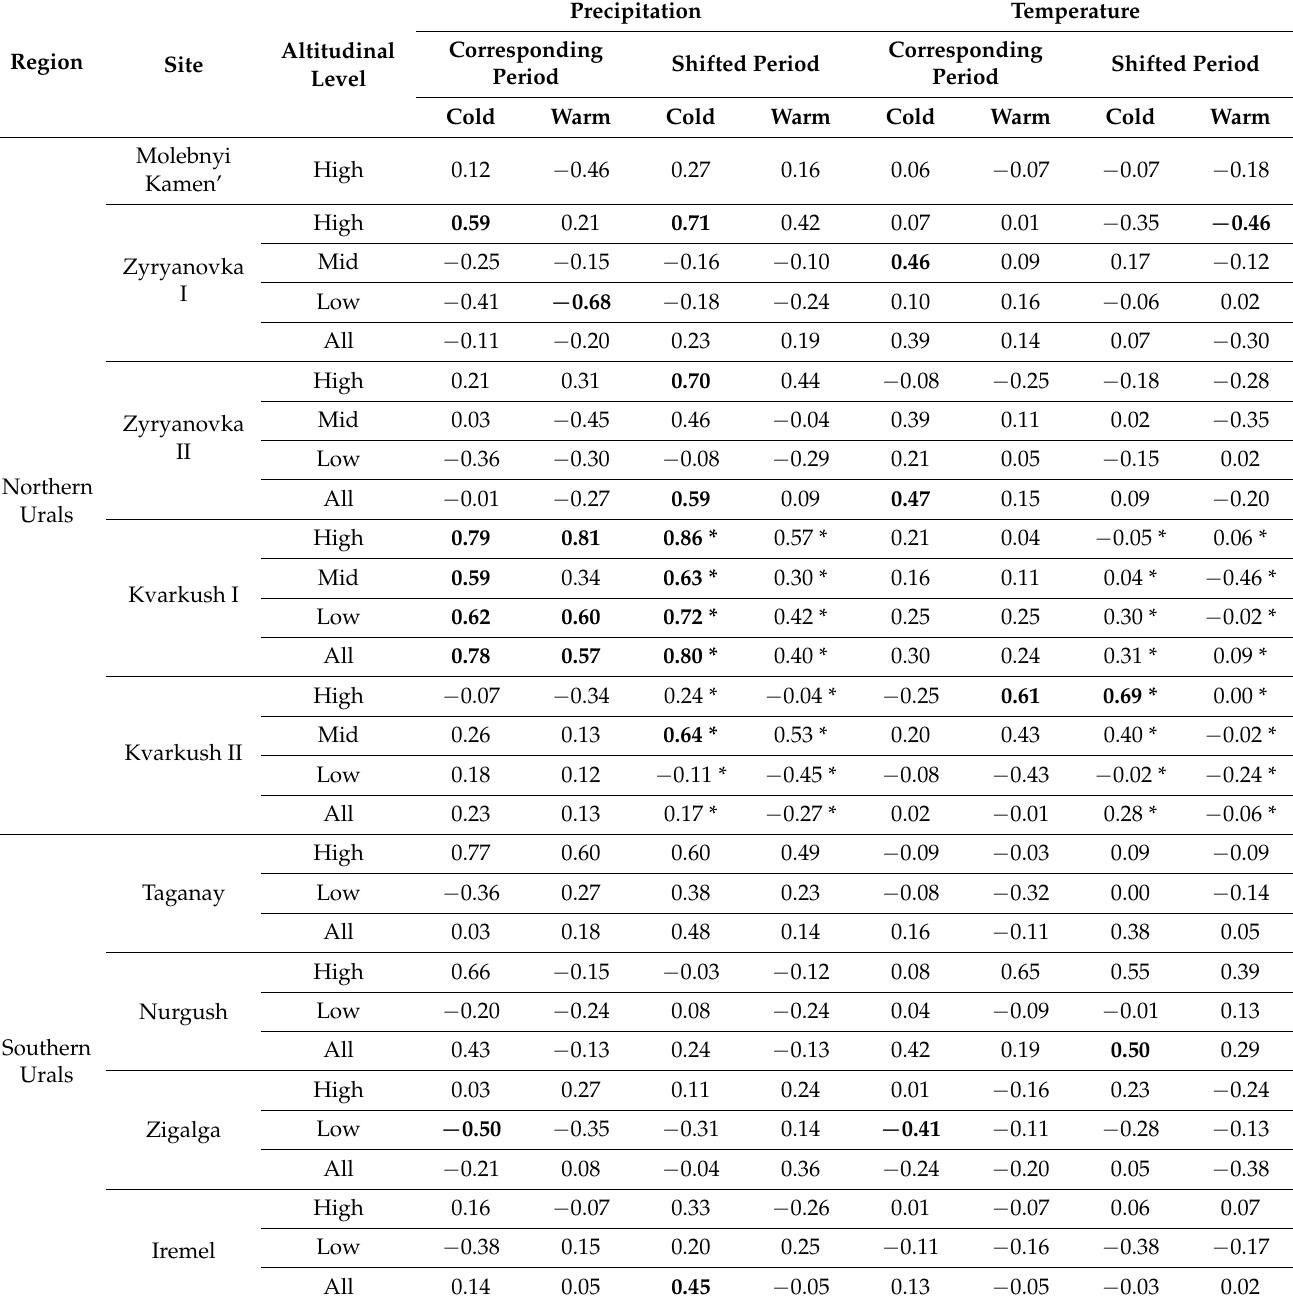
Table 3. Spearman correlation coefficients calculated by relating the number of recruited J. sibirica shrubs on different altitudinal levels and climate variables. Correlations were calculated for 5-year periods in the cold (November–January) and warm (June–August) seasons. Significant values at p < 0.05 are indicated in